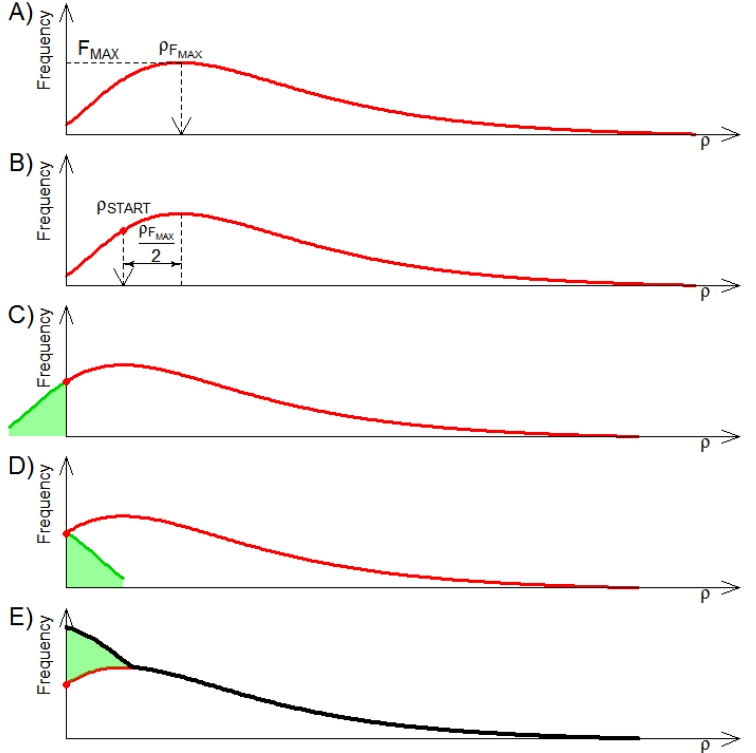
Figure 6. Schematic representation of the computation of the standardized composite histogram (SCH) from the point cloud in the horizontal plane, conducted for each quadrant separately and subsequently combined (see text for explanation of histograms ( A – E )).